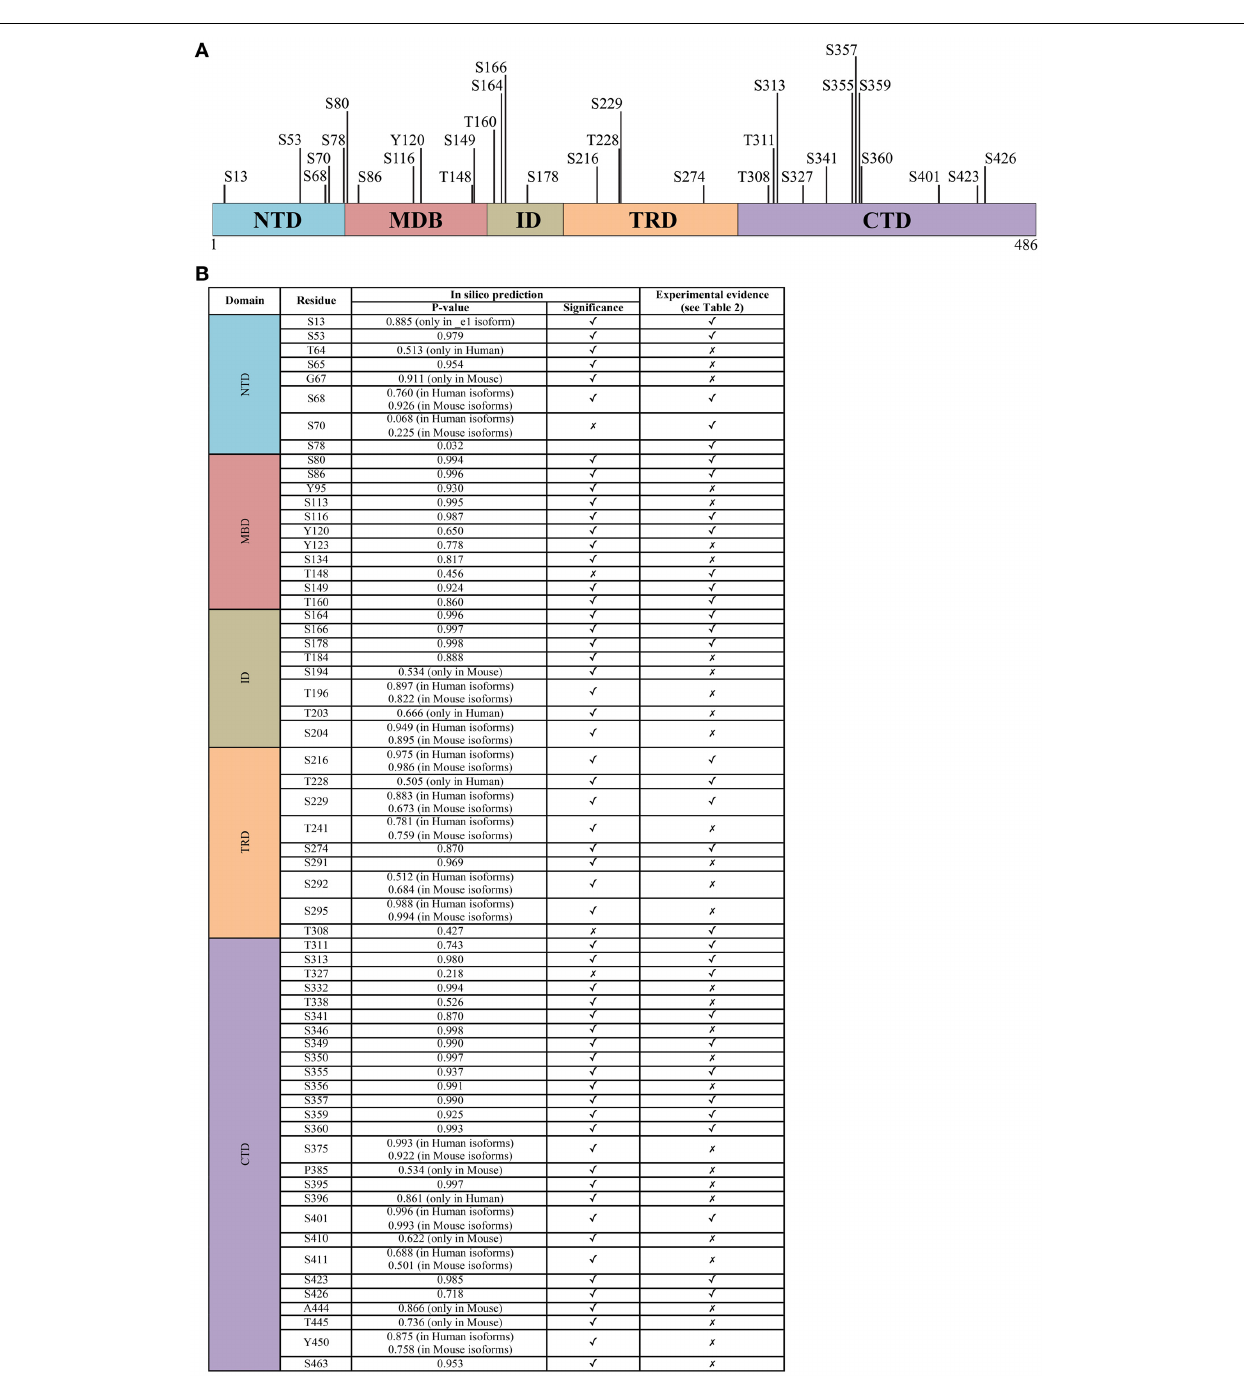
FIGURE 2 | The phosphorylation signature of MeCP2. (A) All experimentally determined phosphorylation sites of MeCP2. The numbering corresponds to the hMeCP2_e2 isoform. (B) The probability score of phosphorylation sites within MeCP2 identified in silico by GPs 2.0 and